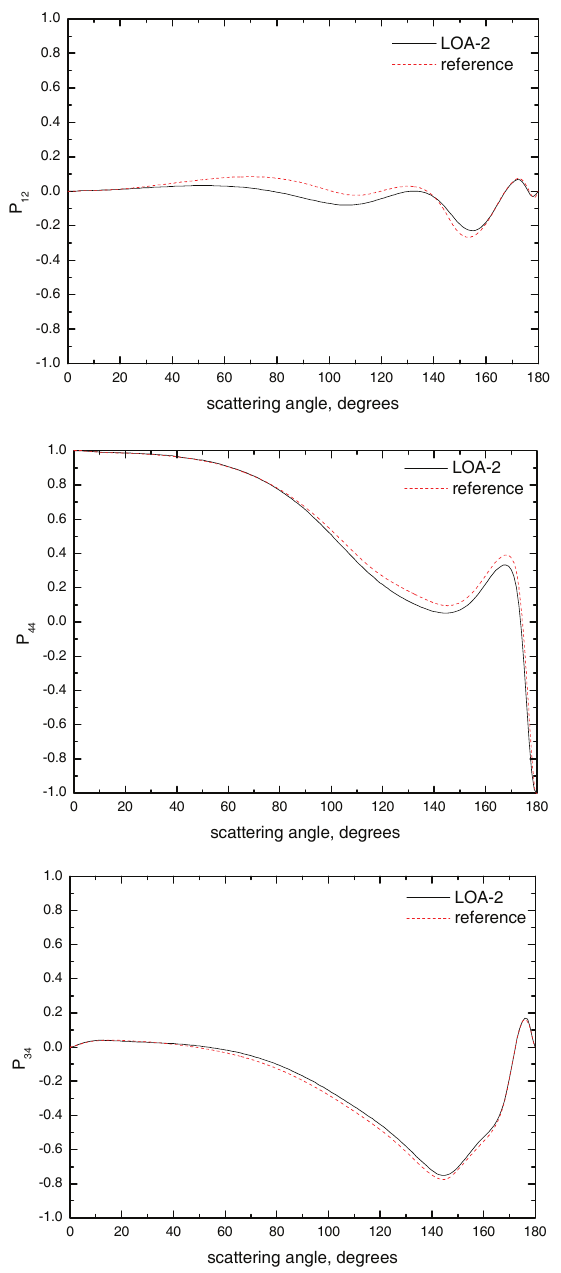
Fig. 16. The comparison of the phase matrix elements derived in retrievals by the LOA-2 algorithm with the reference phase function (λ = 550nm ) .